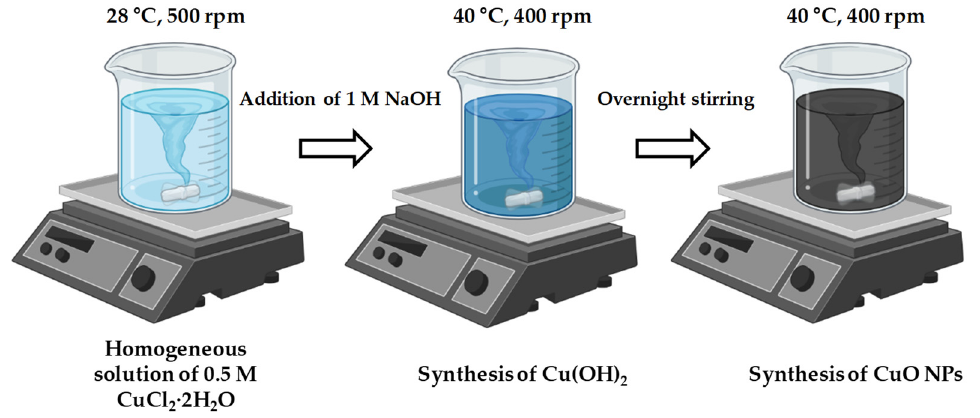
Figure 1. Schematic representation of CuO NPs synthesis.